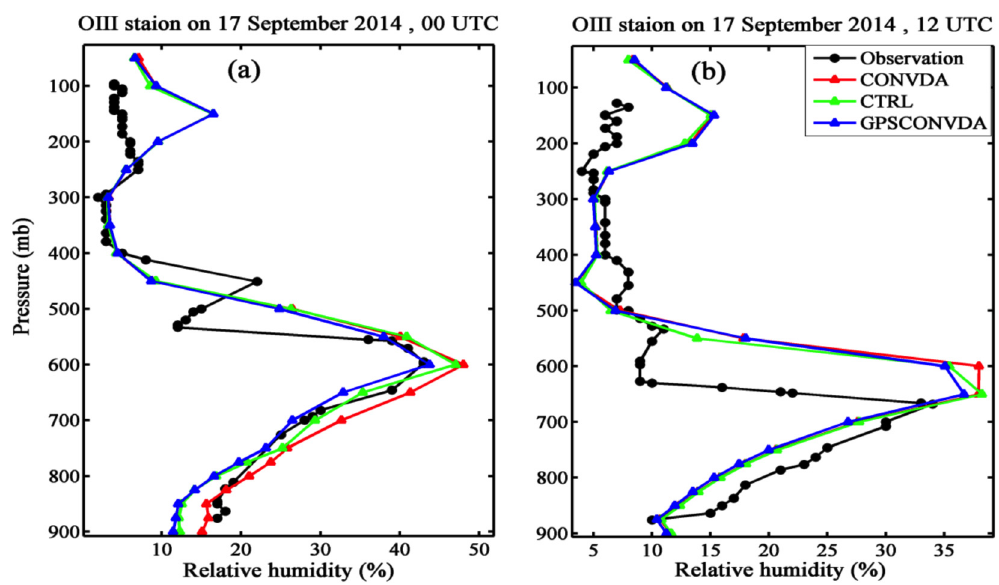
Figure 5. Comparison of the WRF predicted vertical profiles of relative humidity (%) from different experiments with radiosonde obser- vations at Tehran Mehrabad airport (OIII: latitude=35.68°N, longitude=51.35°E) in (a) 12h and (b) 24h simulation. The WRF start the pre- diction on September 16, 2014, 12